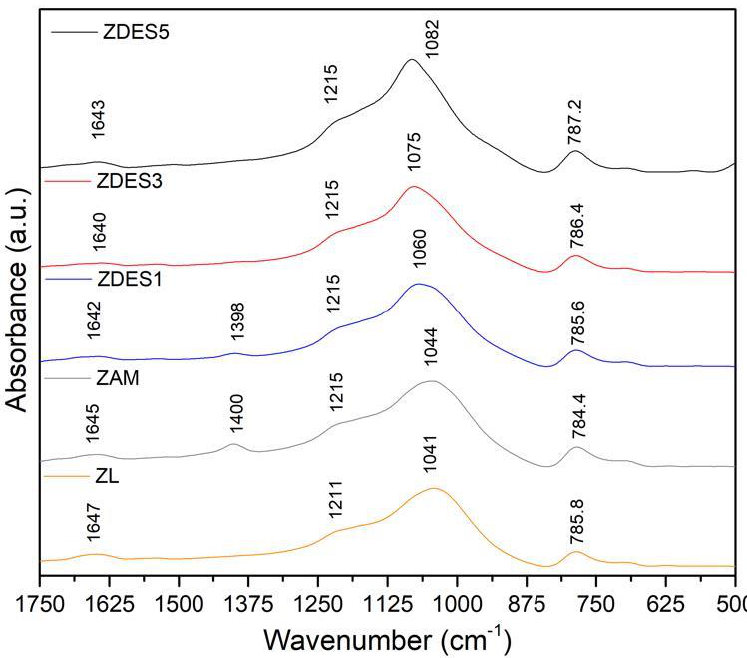
Figure 6. FTIR spectra in the range of 1750–500 cm − 1 of the raw material (ZL); ammonia-exchanged sample (ZAM); and dealuminated samples (ZDES1, ZDES3, and ZDES5). On the other hand, the vibrations in the region of 1600–4000 cm − 1 correspond to the presence of zeolitic water [37]. Figure 7 shows peak intensities around 3437 cm −1 , which reveals the formation of silanol nest defects in vacant Al sites left by dealumination [5,38]. That band belongs to the Si-OH group bound to hydrogen in nest defects, and contributes to hydrogen bonds supported by free and crystalline water molecules.